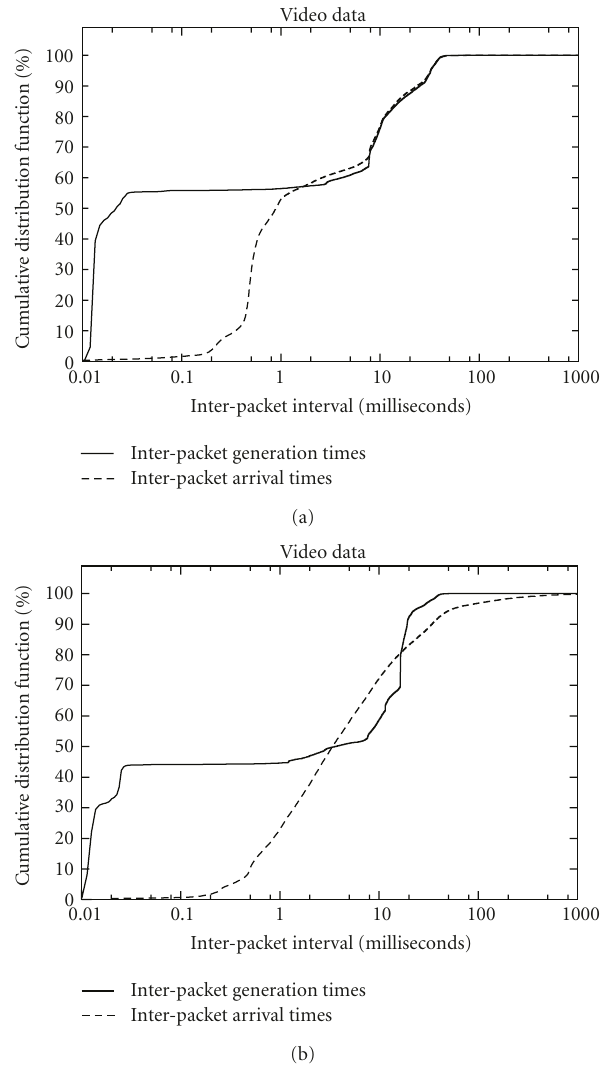
Figure 22: Cumulative distribution function for the interpacket generation interval and interpacket arrival interval in a scenario with one hop (b) and ten hops (a).